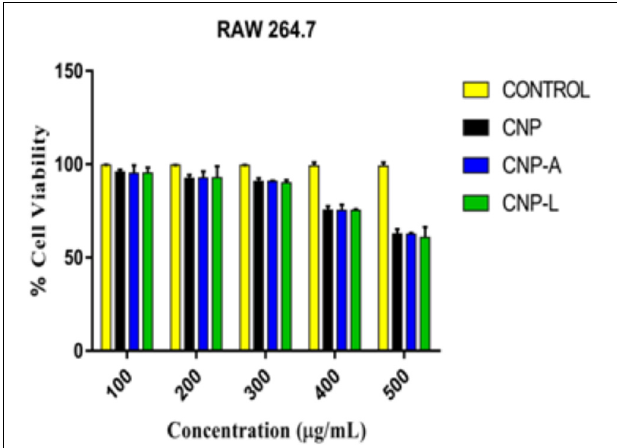
FIGURE 6 | Assessment of cytotoxic activity of various as-synthesized CNPs against mouse macrophages 264.7 cells. Macrophages were treated with increasing concentration of CNPs for 24 h: cell viability was determined by MTT assay. Experiments were performed in triplicate; results are shown as mean ±